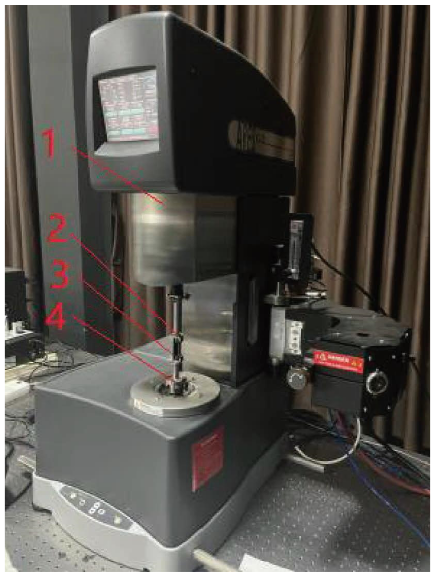
Figure 3: Static tension of composite gels as measured by a Figure 6. In this picture, the part marked 1 is the controller, the part marked 2 is DC power, the part marked 3 is the fxed clamping head, and the part marked 4 is the testing spec- imen. Te part marked 5 is the moveable clamping head, and the part marked 6 is a screw. Te part marked 7 is an infrared thermography camera (USA Teledyne Co., Ltd., Flir), and